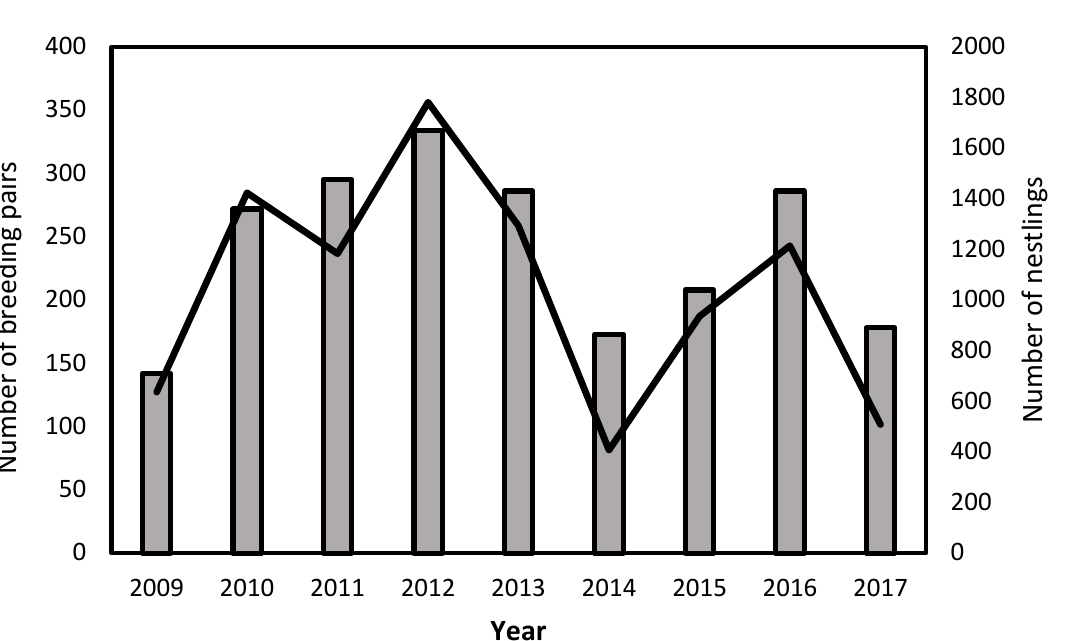
Figure 3. The number of breeding pairs (columns) and the yearly number of nestlings ringed (line) from 2009 to 2017.